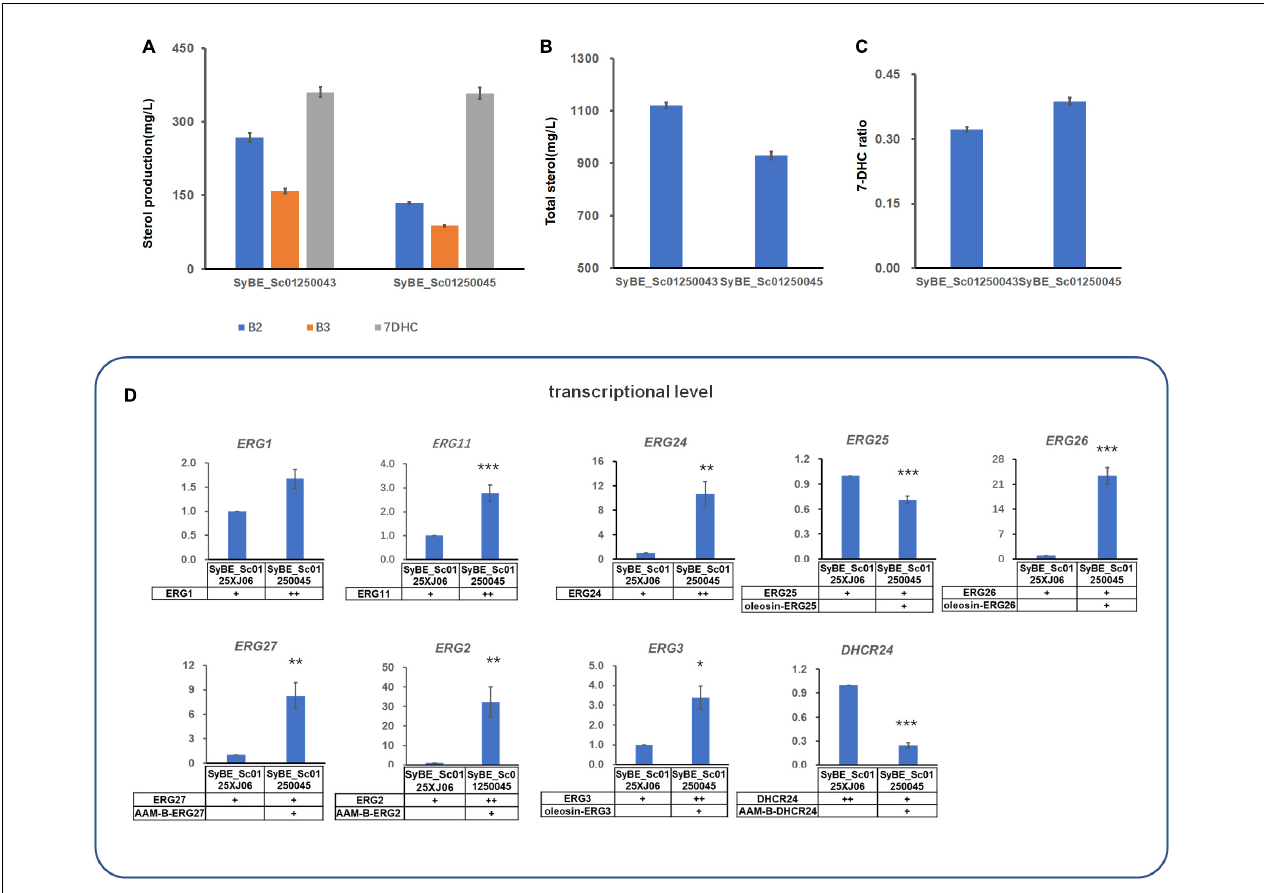
FIGURE 5 | 7-DHC production and metabolic flux changes caused by adding ER-targeted ERG2 and ERG3 to strain SyBE_Sc01250043. (A) B2, B3, and 7-DHC amounts change between SyBE_Sc01250043 and SyBE_Sc01250045. (B) Total sterols of the two strains. (C) 7-DHC ratios of the two strains. (D) The modified post-squalene pathway gene transcriptional levels in strain SyBE_Sc01250045 compared with the control strain SyBE_Sc0125XJ06. All data were from at least triplicate experiments. T -test was conducted between the corresponding strain and the control strain SyBE_Sc0125XJ06. Significance levels of t -test: * P < 0.05, ** P < 0.01, *** P <